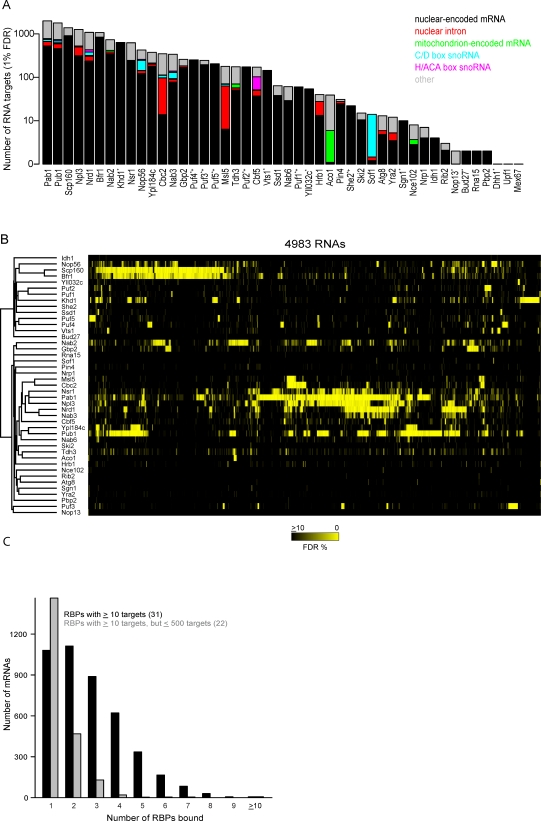
Diverse Binding Specificity among RNA-Binding Proteins(A) Estimated number of RNA species (y-axis) associated with each protein in this survey (x-axis) at a 1% FDR threshold. The proportions of bound RNAs in each of several classes are represented by colors: nuclear-encoded mRNAs (black), nuclear introns (red), mitochondrion-encoded mRNAs (green), C/D box snoRNAs (cyan), H/ACA box snoRNAs (magenta), and all other RNAs (grey), which includes ribosomal RNAs, LSR1, NME1, SCR1, SRG1, TLC1, mitochondrial introns, unannotated “intergenic” transcripts (named IGR* and IGX* in Datasets S1–S3), tRNAs, and splice junctions. An asterisk (*) denotes proteins whose targets were identified using DNA microarrays that did not contain probes designed to detect most non-nuclear-encoded mRNAs. Six proteins from our previously published work (Puf1–5 and She2) are also included (marked with a plus sign [+]).(B) Hierarchically clustered heat map representation of RBPs and their RNA targets. Rows correspond to specific RBPs and columns correspond to RNAs. The certainty that the RNA is a bona fide target of the specified RBP is represented by a continuous black (10% FDR or greater) to yellow (0% FDR) scale.(C) The distribution of the number of RBPs bound per mRNA at 1% FDR threshold is shown as a bar plot. The black bars represent the values for the 31 RBPs associated with at least ten mRNAs, and the grey bars represent the 22 RBPs associated with at least ten mRNAs, but fewer than 500 mRNAs.